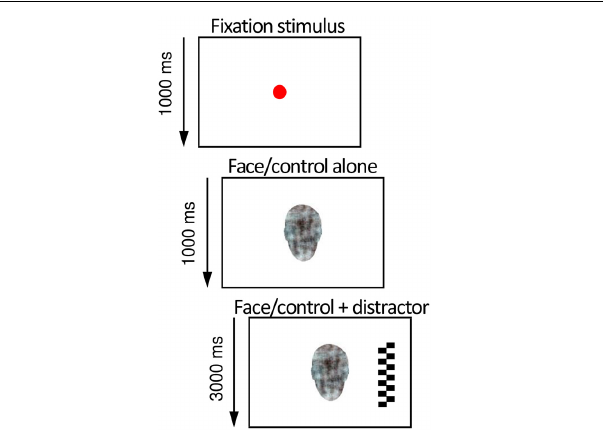
FIGURE 1 | Illustration of the overlap paradigm used in the eye-tracking experiment to assess infant’s attention to social signals of emotion. After the infant looked at an animated fixation stimulus in the center of the screen (depicted here as a red circle), a face or a non-face pattern and subsequently a high-contrast lateral distractor were presented. The probability of attention disengagement from the central to the lateral stimulus was analyzed from the eye tracking data and used as a measure of attention to non-face patterns and neutral, happy, and fearful